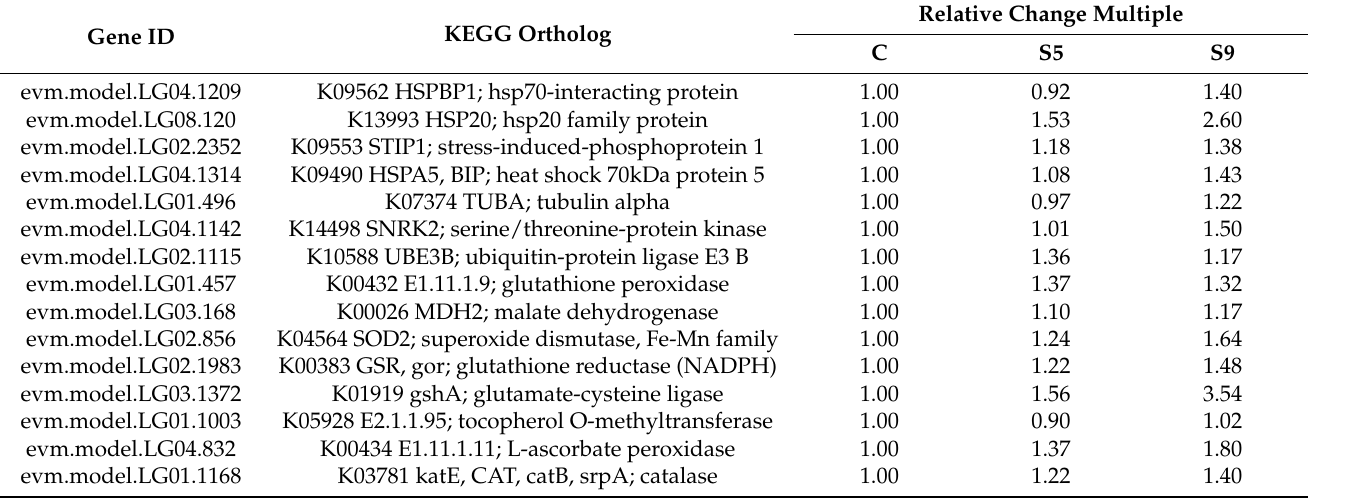
Table 3. Changes in expression of resistance-related genes under salt stress (expressed as ploidy).